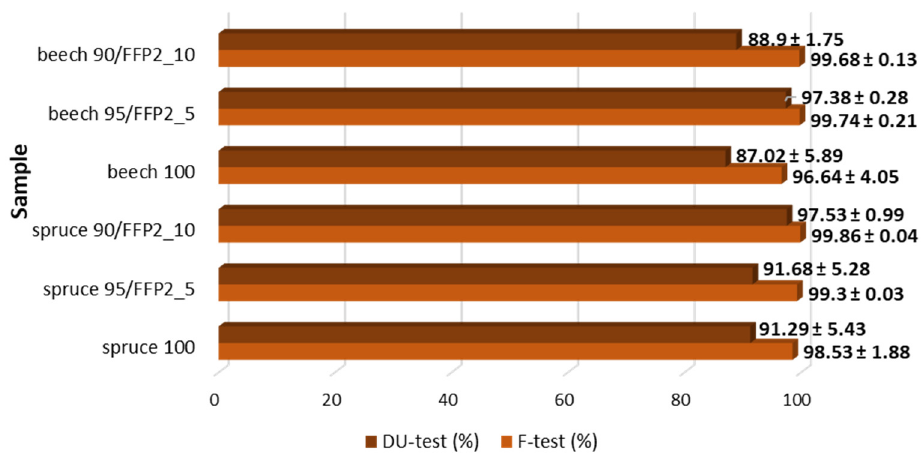
Figure 5. Mechanical